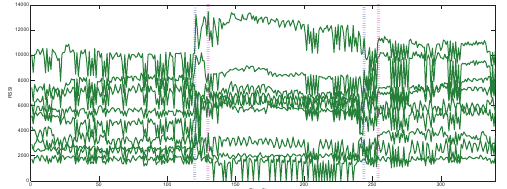
Figure 16: Recognition latency: blue dot vertical line indicates the ground-truth time point of posture transition, pink dot ver- tical line indicates the recognition time point detected by our